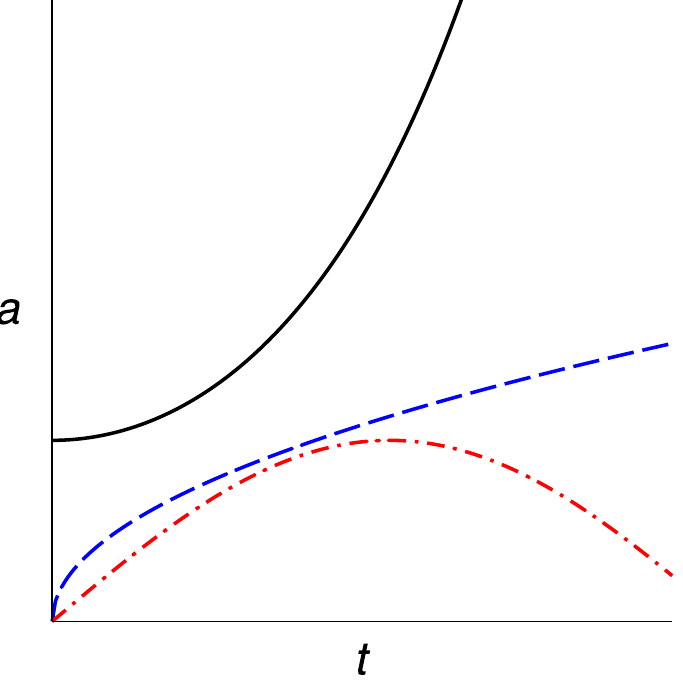
Figure 2. The scale factor a ( t ) for the problems discussed. The curves correspond, respectively, to the catenary/minimal surface of revolution problems (black, solid); the Poincaré half plane geodesics problem (blue, dashed); and the gravity tunnel problem (red,